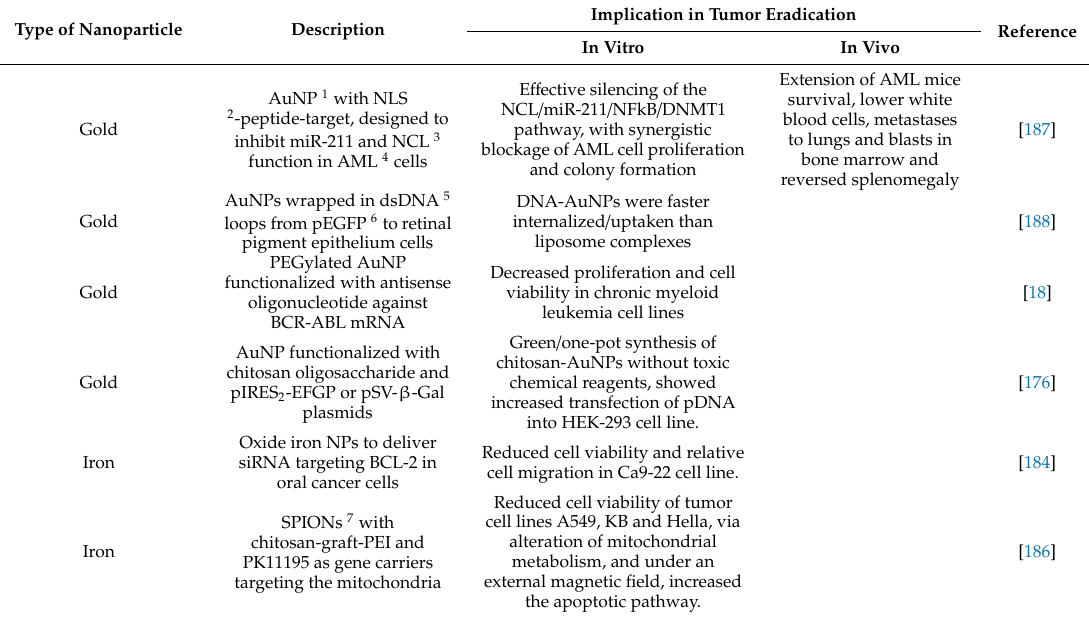
Table 2. Application of metallic nanoparticles in cancer